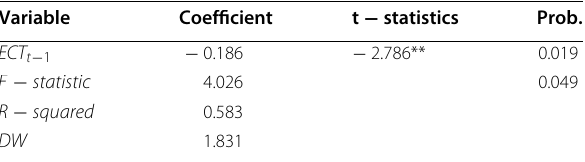
Table 5 Estimated short-run